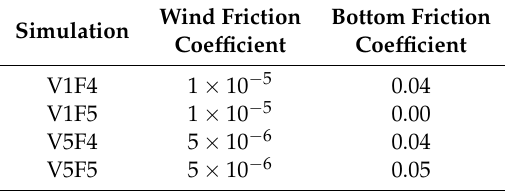
Table 1. Simulation parameters.